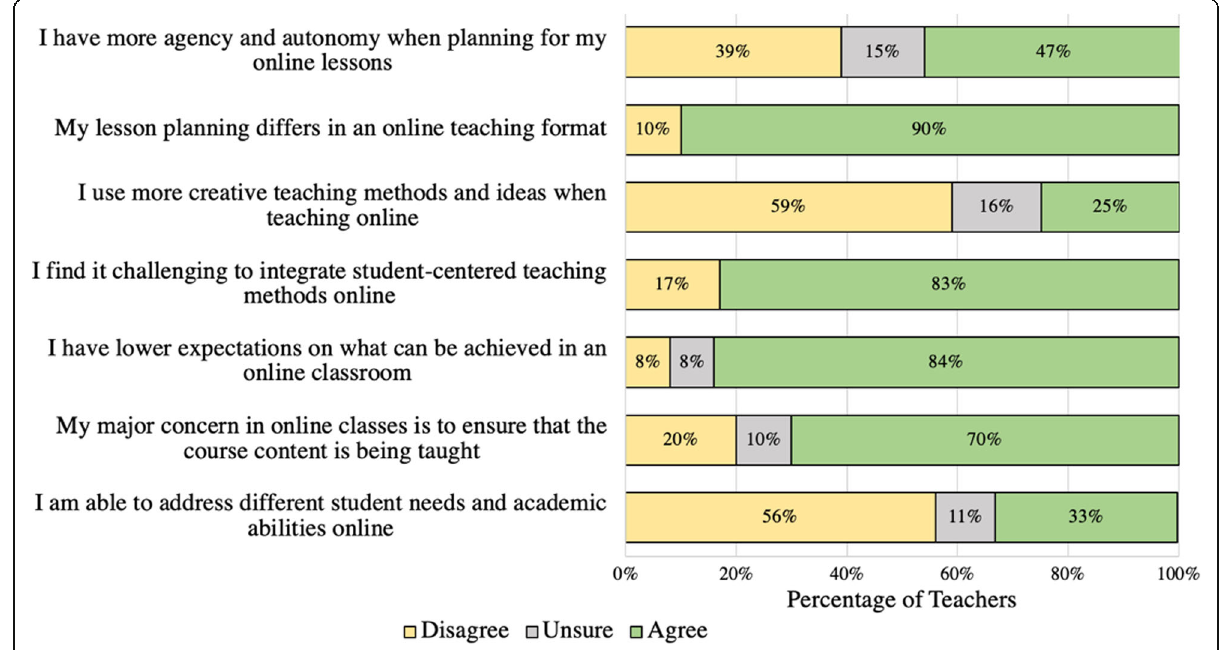
Fig. 3 Teachers ’ responses on their curriculum planning and implementation during